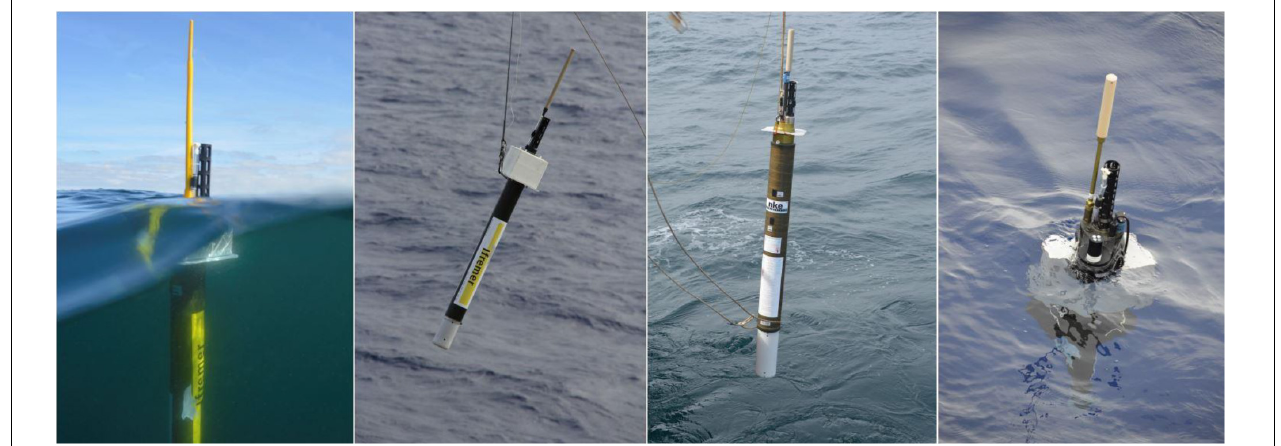
FIGURE 13 | From left to right : Arvor Argos-2 (courtesy of Olivier Dugornay/Ifremer); Arvor Argos-3 (courtesy of Ifremer); Deep-Arvor (courtesy of Kévin Balem/LOPS); Provor CTS4 (courtesy of Giorgio Dall’Olmo/Plymouth Marine